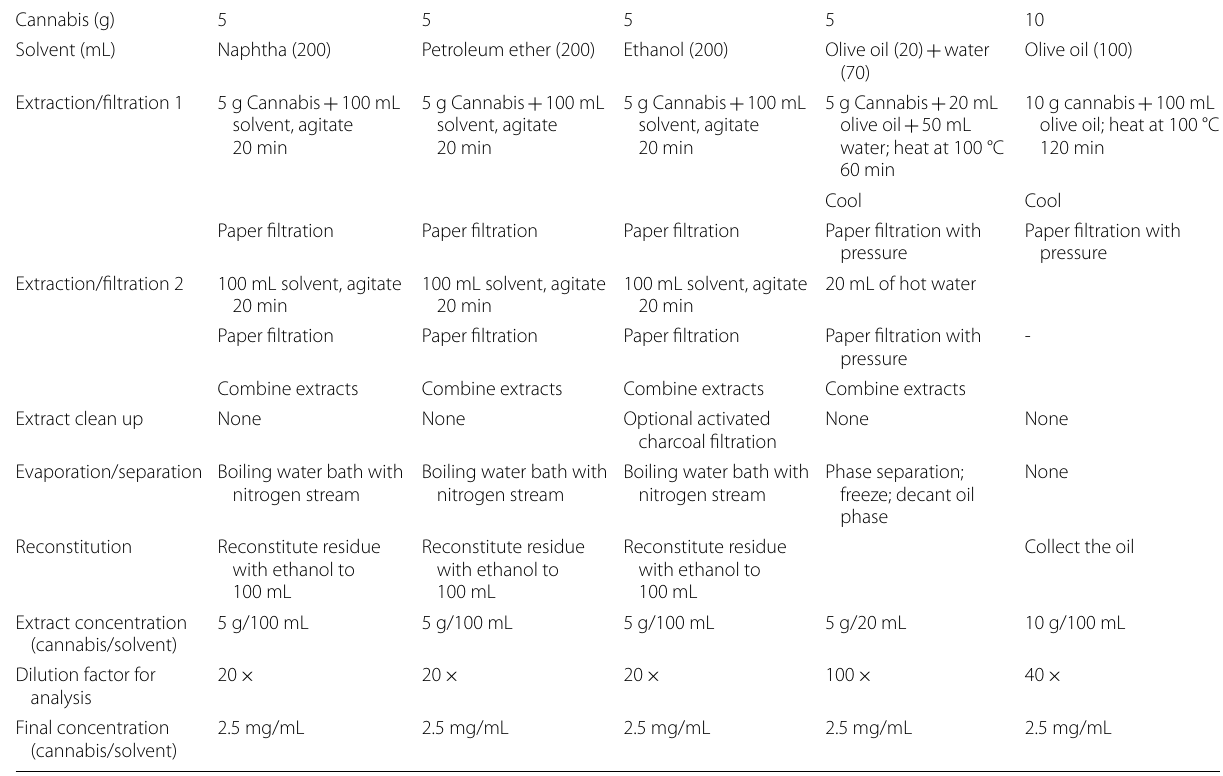
Table 3 Five protocols to extract cannabis by dynamic maceration (Romano and Hazekamp 2013) Cannabis (g)